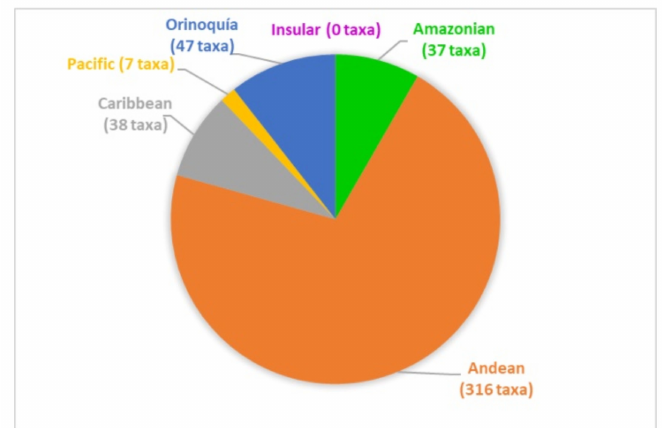
Figure 2. Number of soil microfungal taxa recorded from the natural regions of Colombia.